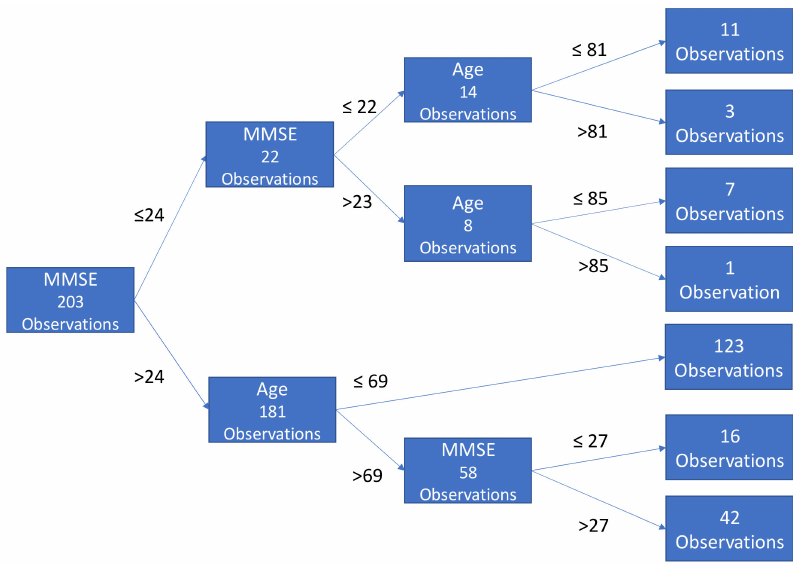
Figure 2. A sample tree classification with a maximum of three branches. MMSE - mini-mental state